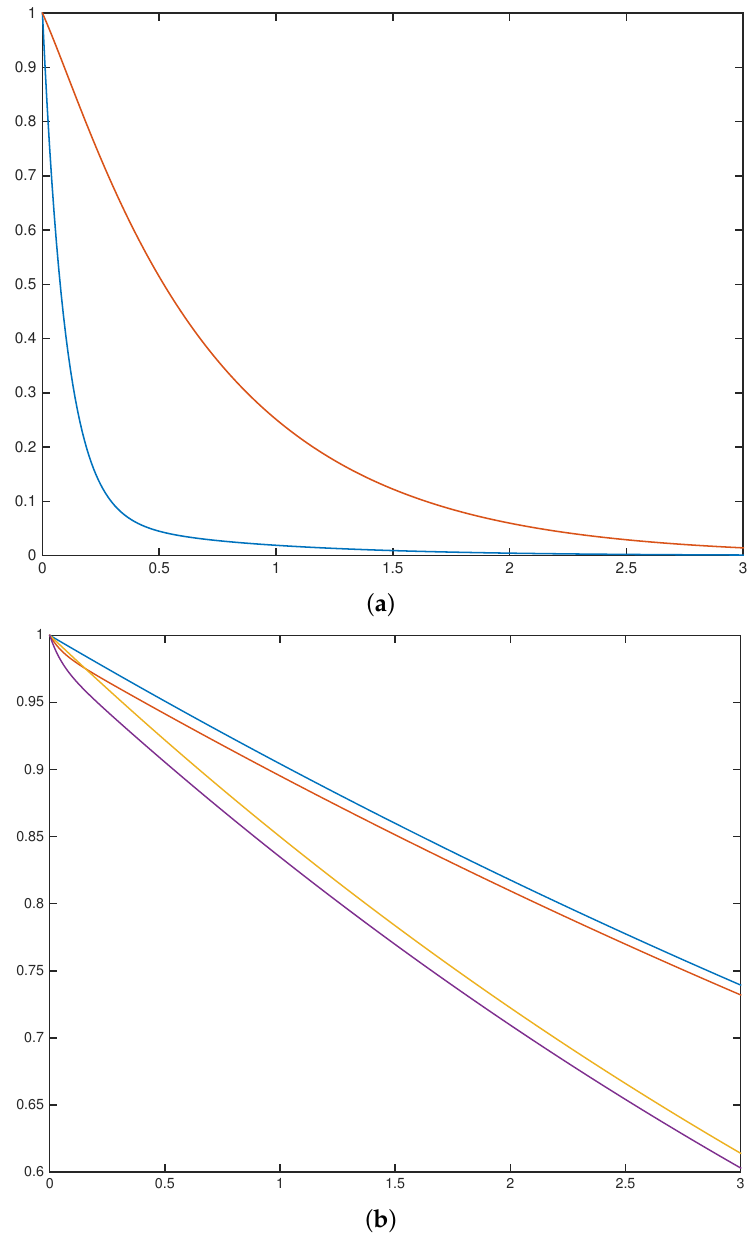
Figure 2. The option price φ 0 ( x ) and φ 1 ( x ) , x > 0, in two “opposite” cases. ( a ): c 0 = 1, λ 0 = 10, b 0 = 0.1 and c 1 = 0.1, λ 1 = 0.1, b 1 = 10. Interest rate r = 0.1. Here, φ 1 (cid:29) φ 0 ; ( b ): c 0 = 1, λ 0 = 0.1, b 0 = 0.1, and c 1 = 0.5, λ 1 = 10, b 1 = 10, Two pairs of the curves correspond to different interest rates, r = 0.05 (top pair of curves) and r = 0.1 (lower pair of curves). In both cases, φ 0 ( x ) > φ 1 ( x )